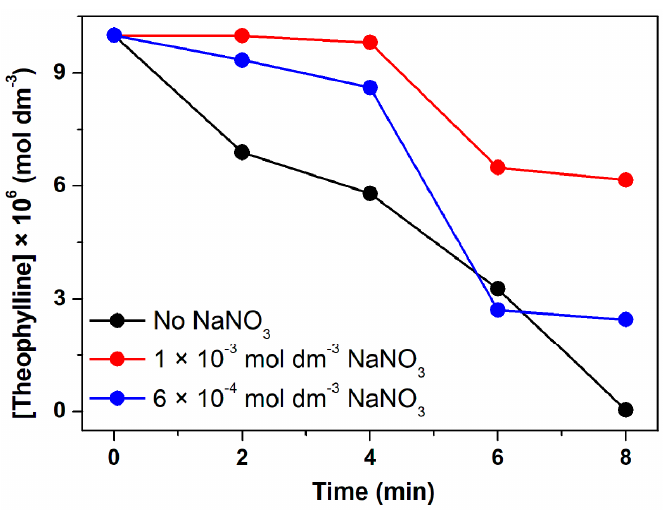
Figure 2. Photo-degradation profile of theophylline (1 × 10 − 5 mol dm − 3 ) in the presence of (black) 5 × 10 − 5 mol dm − 3 H 2 O 2 and in the presence of (red) 1 × 10 − 3 mol dm − 3 and (blue) 6 × 10 − 4 mol dm − 3 sodium nitrate.